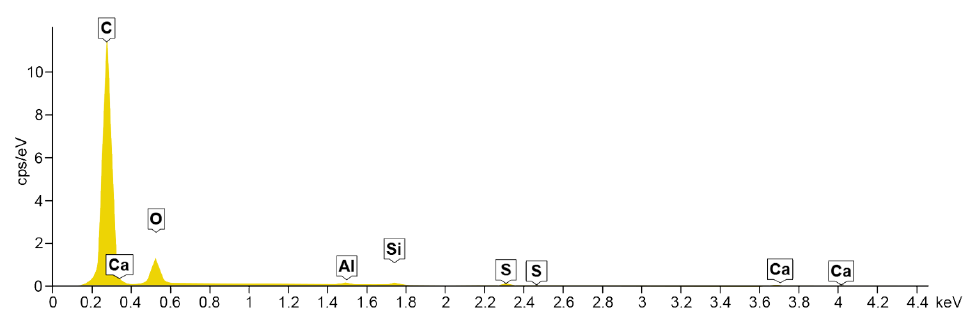
Figure 11. EDS for material M3.